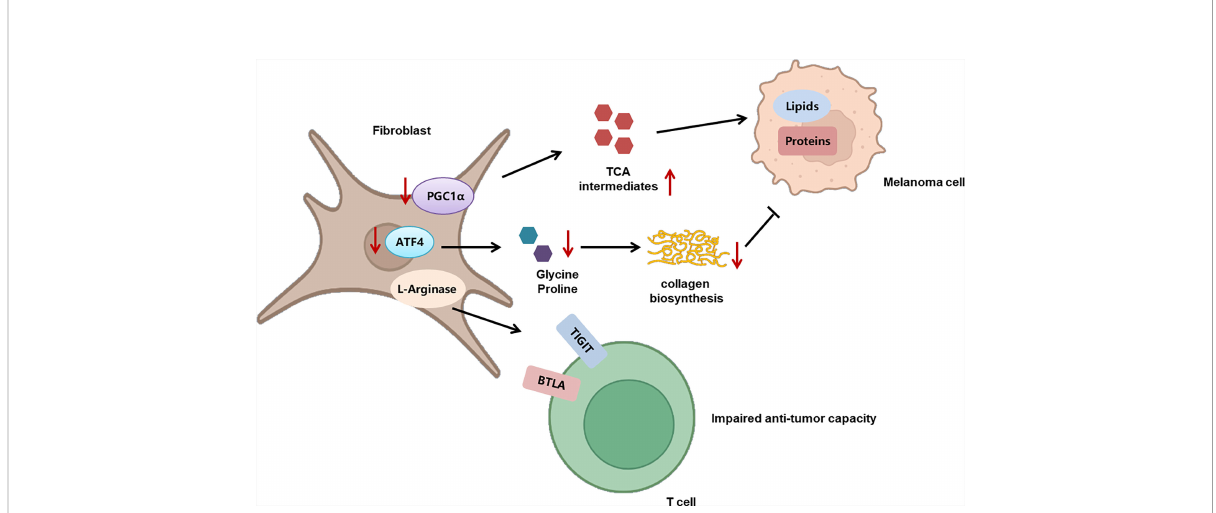
FIGURE 3 The role of metabolism in CAFs and its implication in melanoma progression. The de fi cient mitochondrial function induced by PGC1 a de fi ciency triggers the activation of anaplerotic pathways to provide suf fi cient tricarboxylic acid cycle intermediates, so as to synthesize lipids and proteins to support tumor growth. In addition, CAFs display increased activity of L-arginase, which contributes to TIGIT and BTLA expression on CTLs and impairs the activity of CD8 + T cells. What ’ s more, the knockout of ATF4 in fi broblasts leads to defects in collagen biosynthesis and deposition, so as to result in growth delay of melanoma.